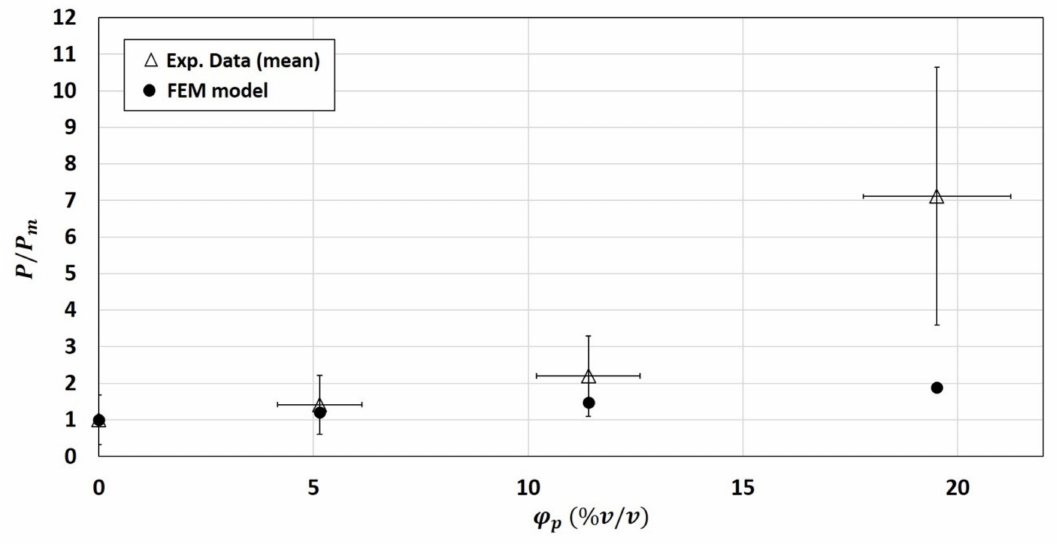
Figure 6. Comparison between experimental and numerical relative permeability P / P m (calculated using the 2-phase